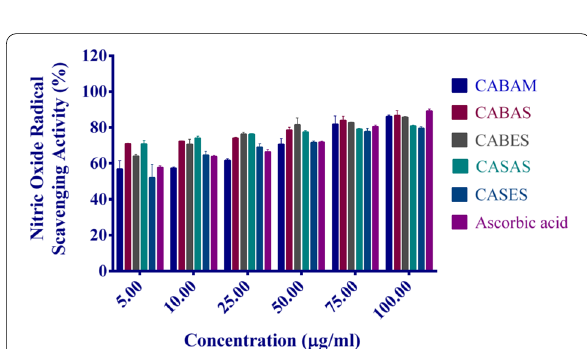
Fig. 2 Nitric oxide radical scavenging activity of C. albidum extracts. Values represent mean standard deviation ( n 3). CABAM C. ± = albidum bark acetone extract obtained by maceration for 30 min, CABAS C. albidum bark acetone extract obtained by sonication for 30 min, CABES C. albidum bark ethanol extract obtained by sonication for 30 min, CASAS C. albidum seeds acetone extract obtained by sonication for 30 min, CASES C. albidum seeds ethanol extract obtained by sonication for 30 min, Asc. Acid ascorbic